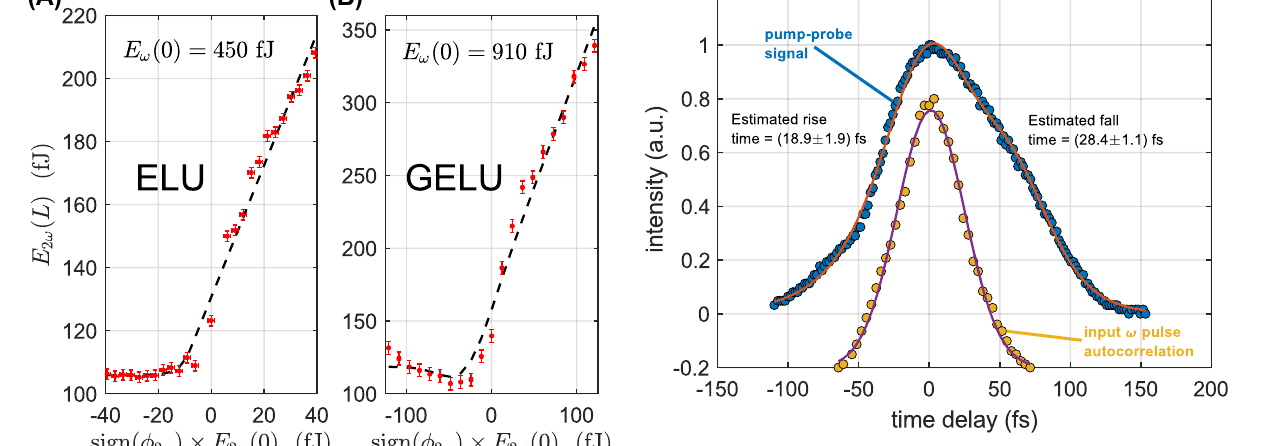
Figure 4: Other variants of the ReLU function can be approximated by tuning the bias pulse energy. For example, the (A) ELU function using bias pulse energy of E 𝜔 (0) = 450 fJ and (B) GELU function using bias pulse energy of E 𝜔 (0) = 910 fJ. Ideal function curves are shown by the dashed black lines, and experimental results with red circles.